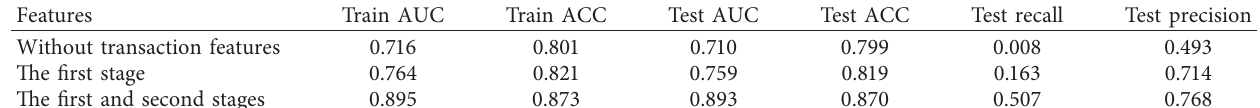
Table 3: Model evaluation indicators of XGBoost algorithm models using different features.